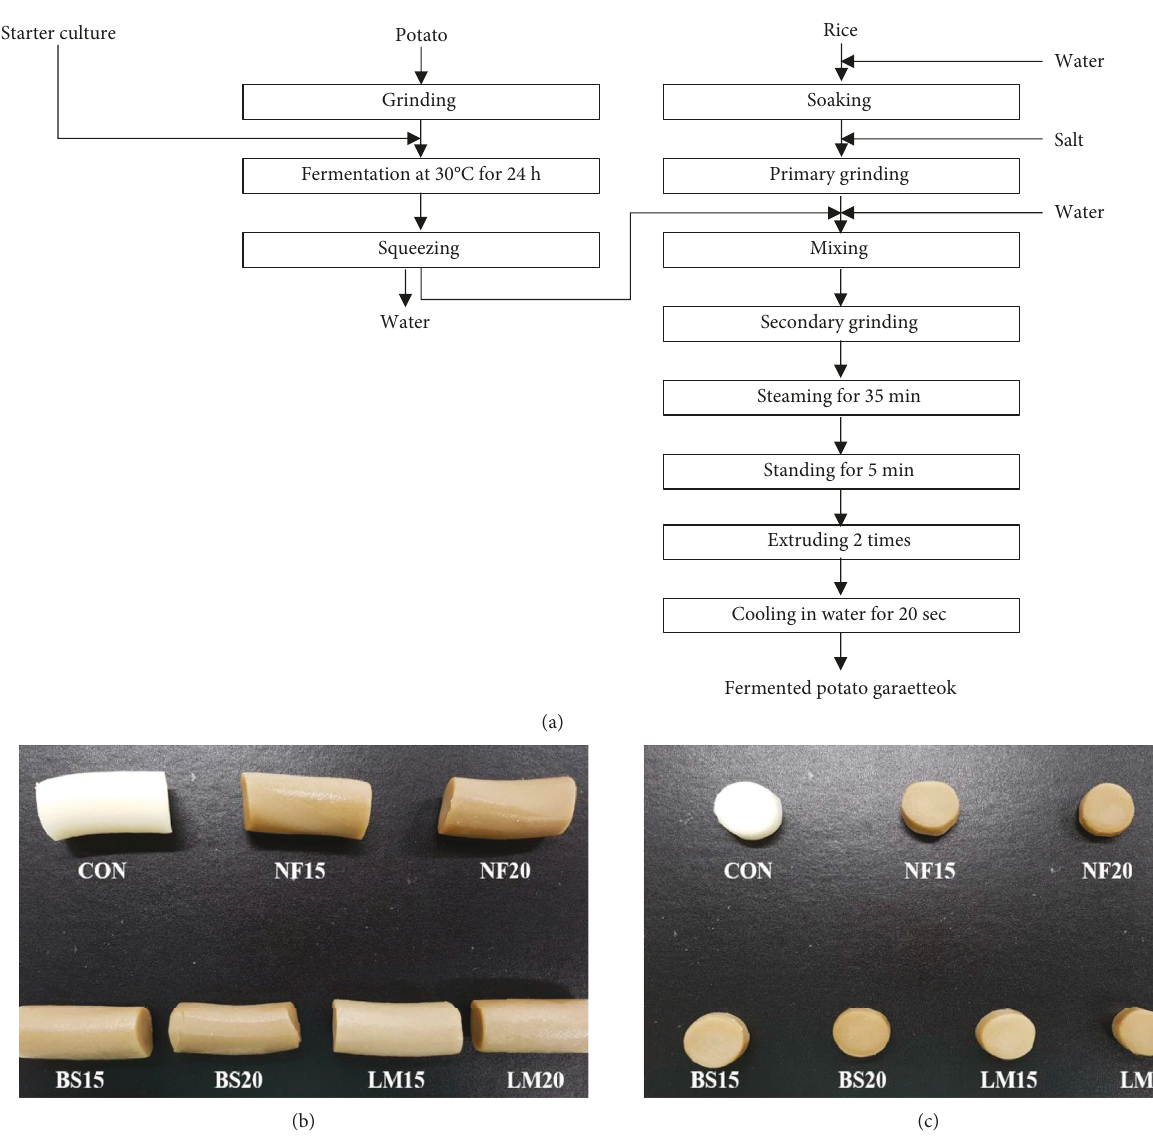
Figure 1: Processing flow chart of potato